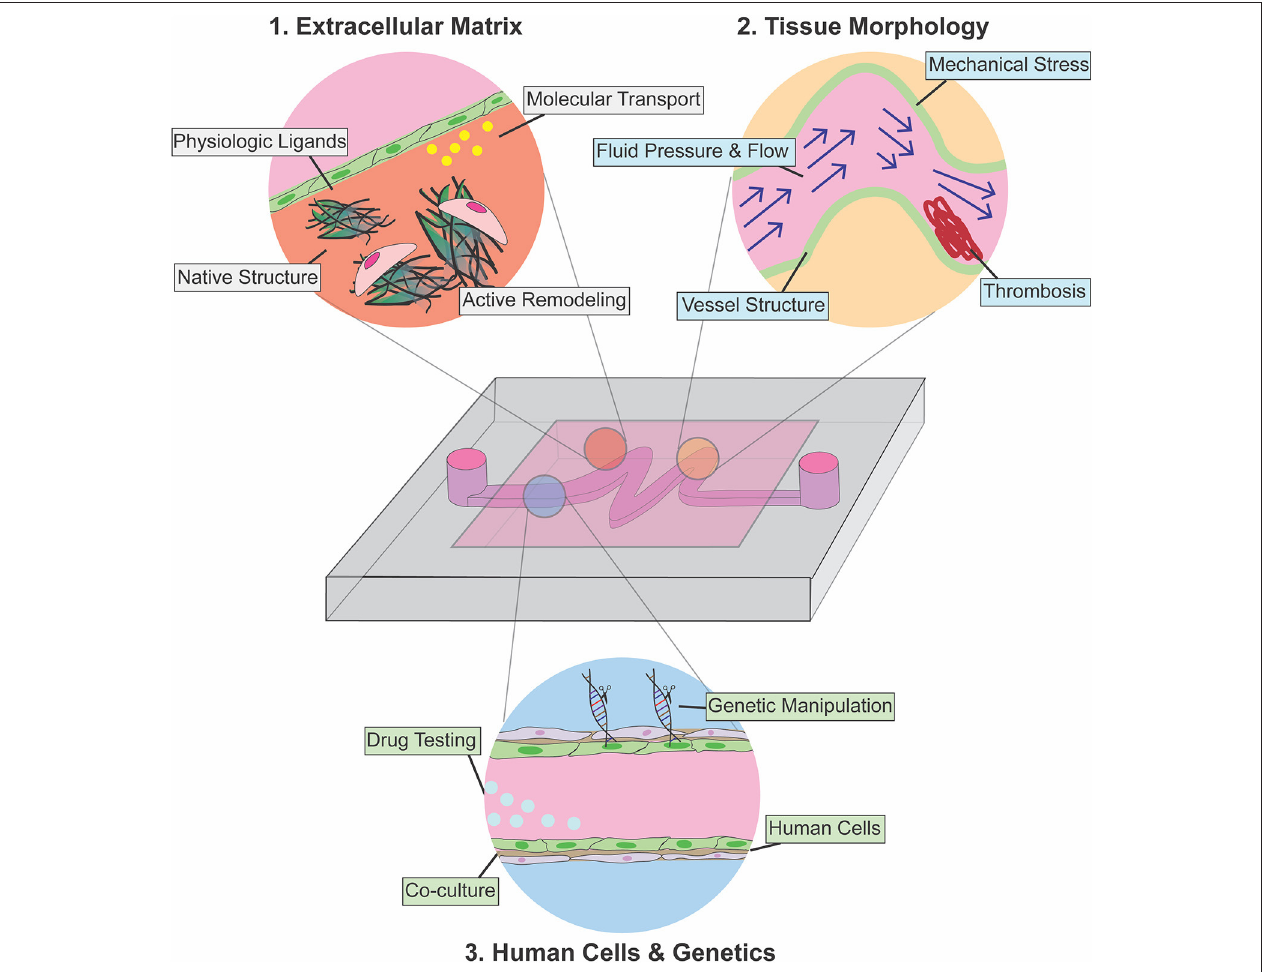
FIGURE 1 | Use of microfluidic devices for modeling cardiovascular disease pathophysiology. Introduction of physiologic ECM enables the investigation of cellular remodeling of ECM in disease conditions (red), and microfluidics also allows patterning and recapitulation of altered tissue morphology and abnormal hemodynamics associated with cardiovascular diseases (yellow). Integration of gene editing with microfluidic technology allows modeling of endothelium-stromal cells interactions within physiological microenvironment in normal development and disease condition (light